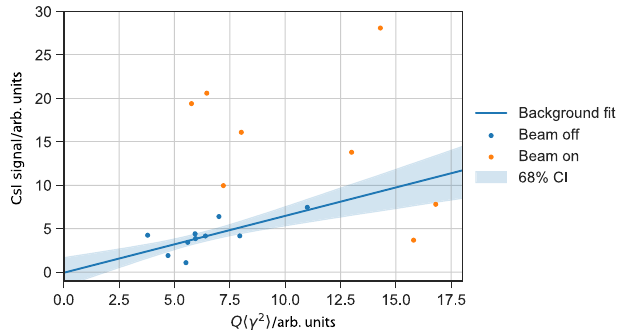
FIG. 3. The total CsI signal as a function of the integrated squared energy of the electron spectrum, and the linear fit to the “ beam-off ” shots. The shaded area represents the 68% confidence interval (CI) for the linear